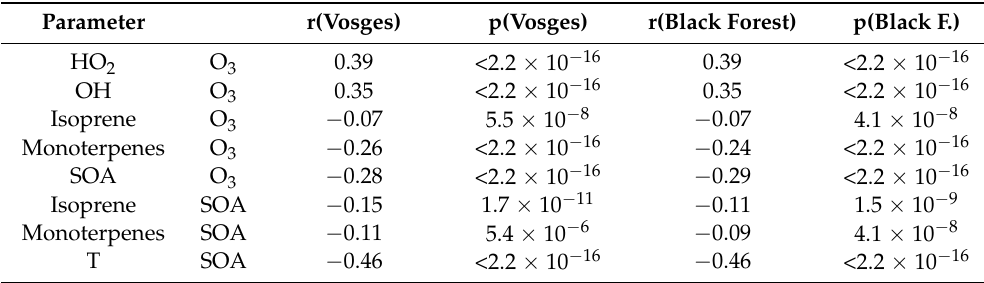
Table 4. Correlation coefficients r of different atmospheric chemistry parameters with ozone simulated for both conditions, i.e., Vosges (Alsace) forest and Black Forest between June and August 2015.